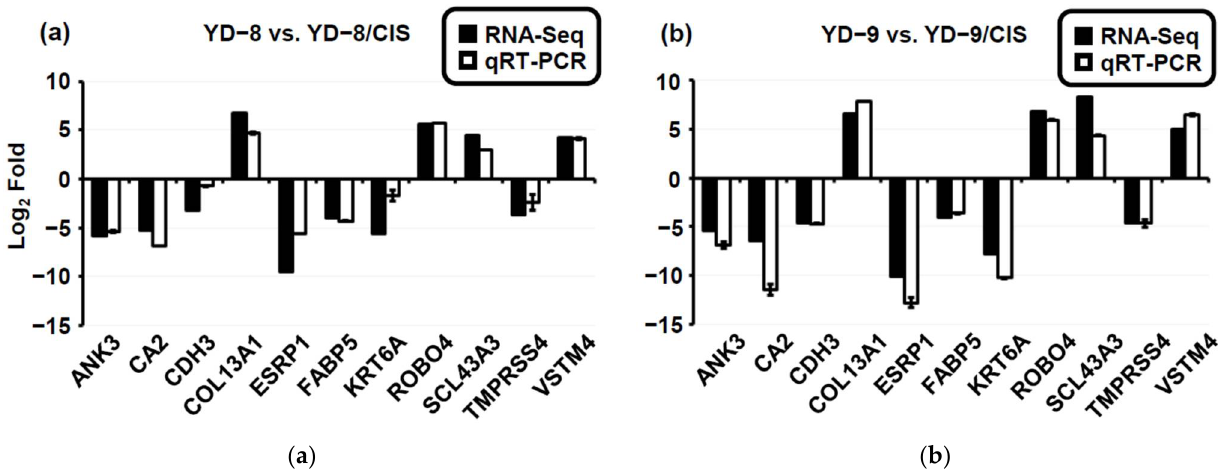
Figure 5. Relative fold change for 11 genes. ( a , b ) Comparison of relative fold change between RNA-Seq and qRT-PCR results in parental (YD-8 and YD-9) and cisplatin-resistant (YD-8/CIS and YD-9/CIS) cell lines ( p < 0.001). In the RNA-Seq results, differentially expressed genes are shown as a black bar. Differentially expressed genes confirmed by qRT-PCR are shown as a white bar. Data are represented as mean values ± SD, n = 3 compared with that in the YD-8 or YD-9 sample, p < 0.01. If log2 of gene expression was below the mean of log2 across the panel of genes, the genes were defined as downregulated; conversely, upregulated genes had values log2 above the mean.